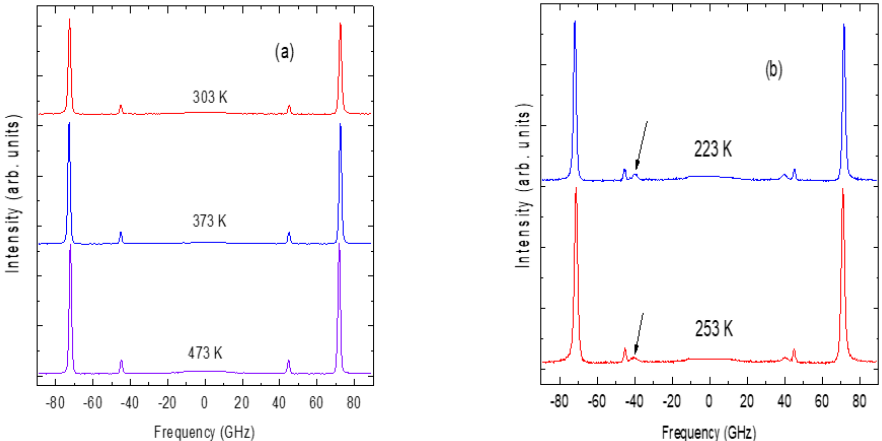
Figure 16. Brillouin spectra of SCT-0.03 measured with FSR of 100 GHz at ( a ) 473, 373 and 303 K and ( b ) 253 and 223 K. (Figure 16a. Reprinted with kind permission from Ref. [83]. Copyright (2020) The Japan Society of Applied Physics).